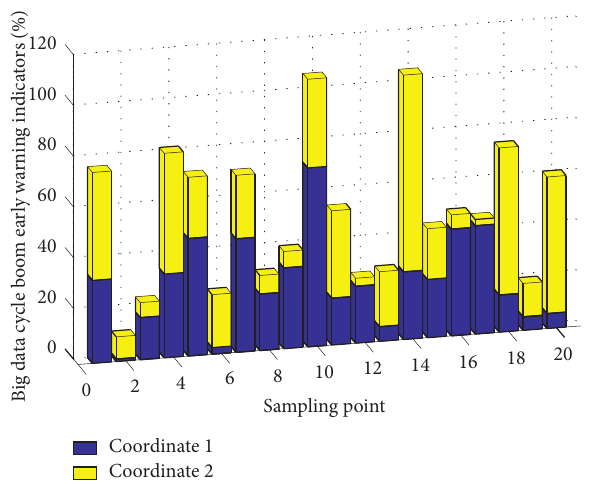
Figure 2: Histogram of big data cycle boom early warning